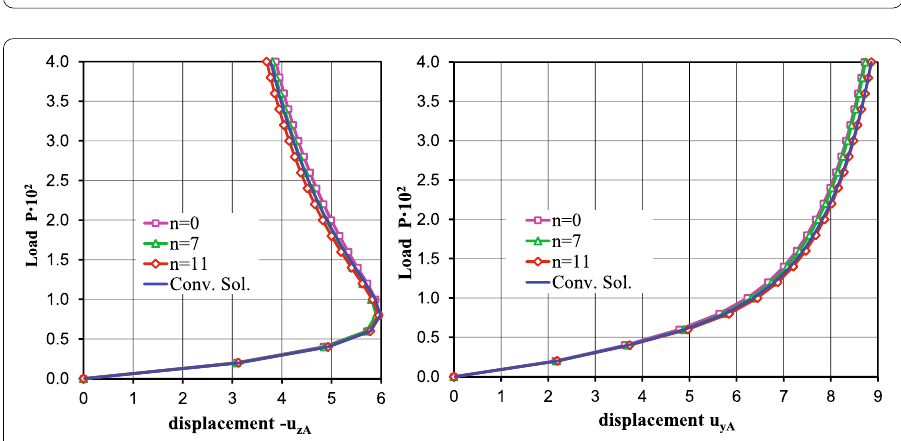
ba Fig. 18 Twisted beam: distorted 4 × 24 mesh 1, a perspective view, b perspective view of the flat projection